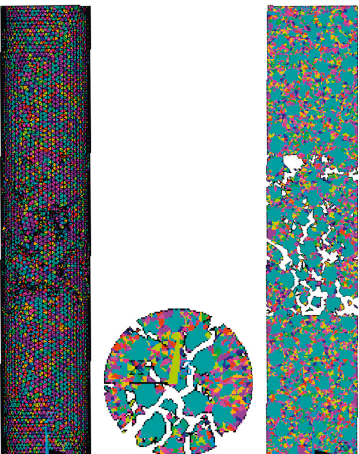
Figure 5: The damaged specimen and damaged cross section of Pre-5.